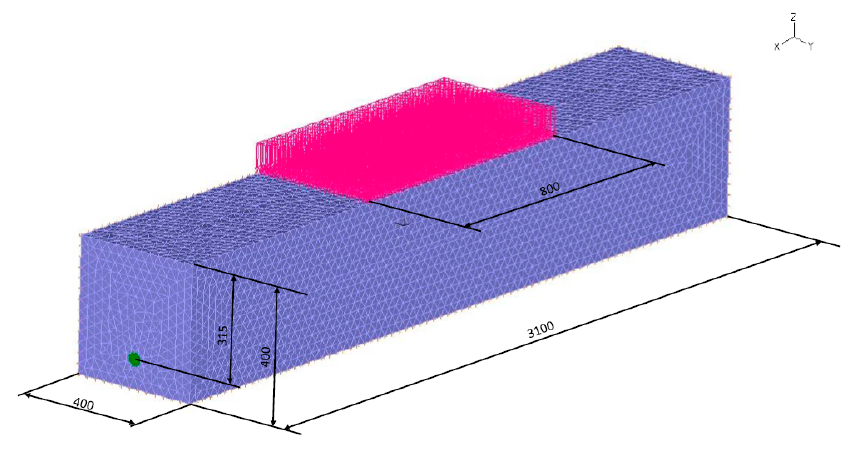
Figure 1. Diagram of the numerical model of the pipe–soil system. (Units in mm) The dimensioned pipe model with the marked section plane is shown in Figure 2.